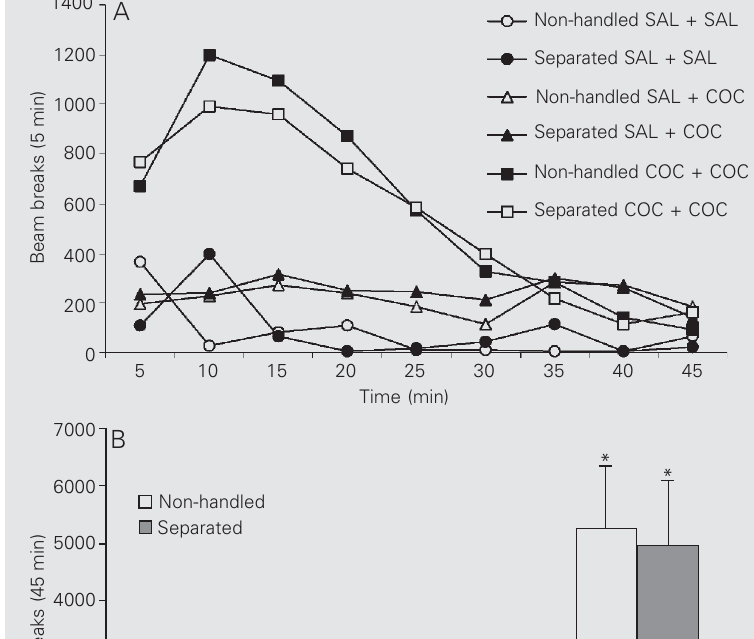
Figure 1. Effect of repeated co- caine injections on body weights of non-handled and early mater- nally separated periadolescent rats. The rats received twice daily injections of 10 mg/kg co- caine, sc , for 5 days. Data are reported as means ± SEM for 10-12 animals per group. *P<0.05 compared to the re- spective saline control (New- man-Keuls test).